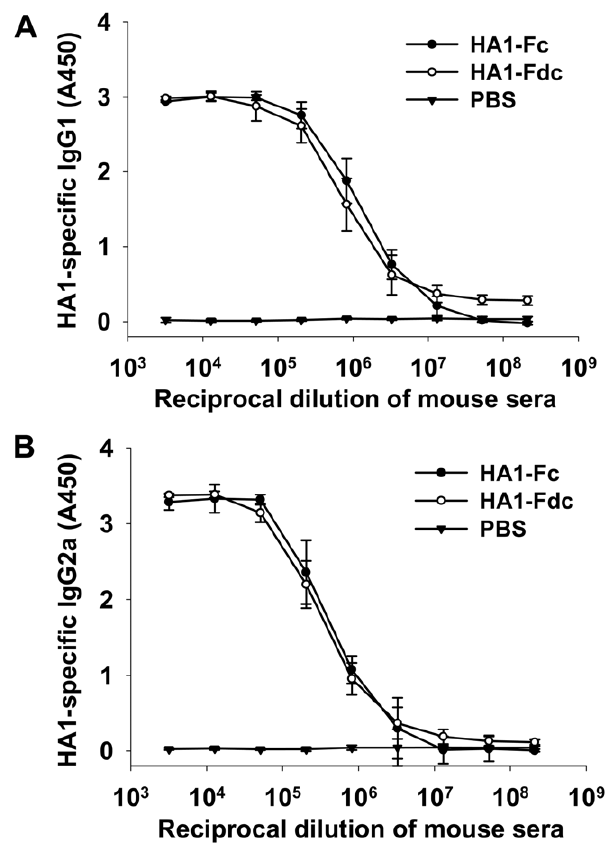
Figure 4. Measurement of IgG1 and IgG2a antibody titers by ELISA in HA1-Fc- and HA1-Fdc-vaccianted mouse sera. PBS was used as the negative control. Ability of IgG1 (A) and IgG2a (B) antibodies binds to the HA1 protein was detected using sera from 10 days post-last vaccination. The data are presented as mean A450 6 SD of five mice per group at various dilution points.